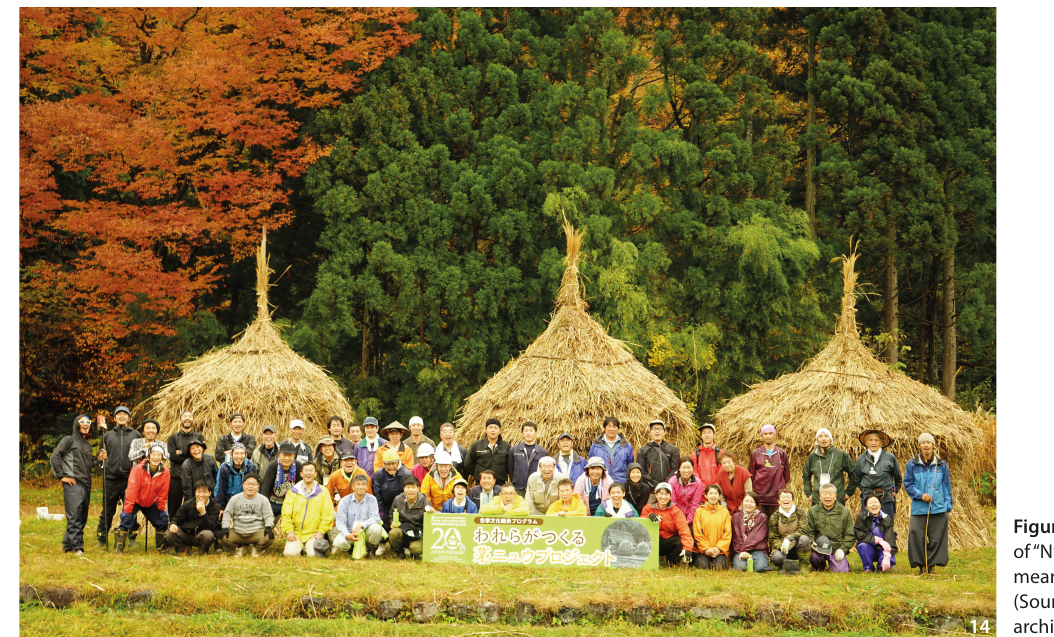
Figure 14 Resurgence of “Nyu,” the traditional means of storing Kaya (Source: Shirakawa mura archives).